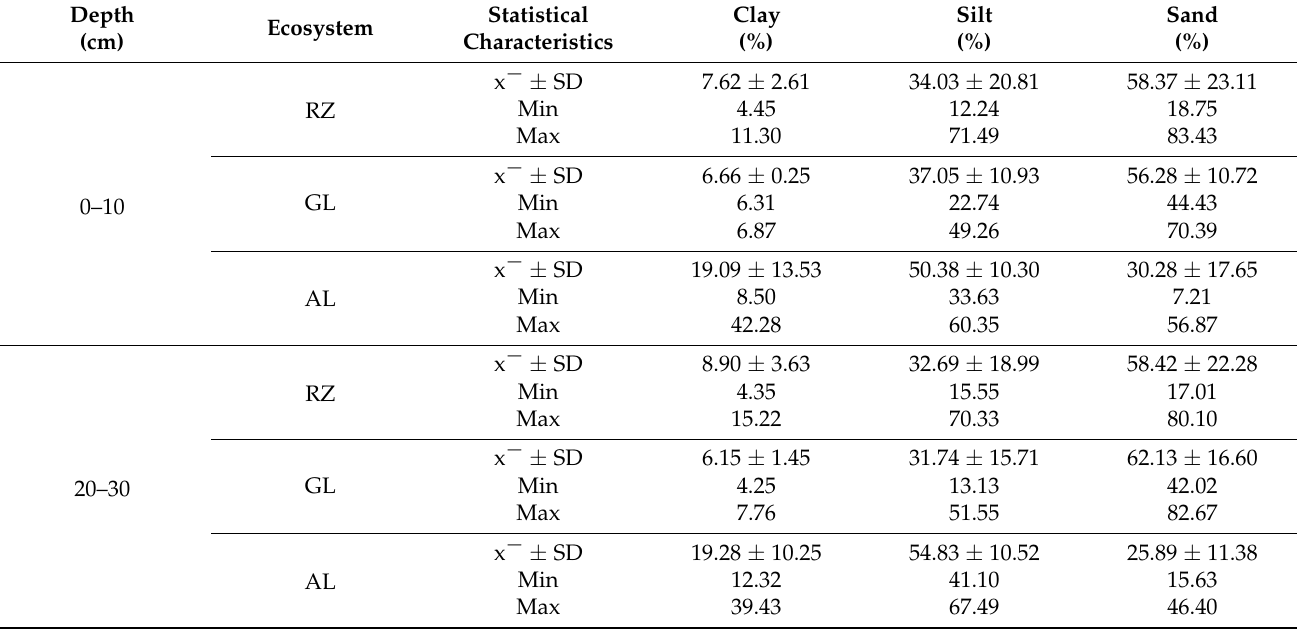
Table 2. Particle size